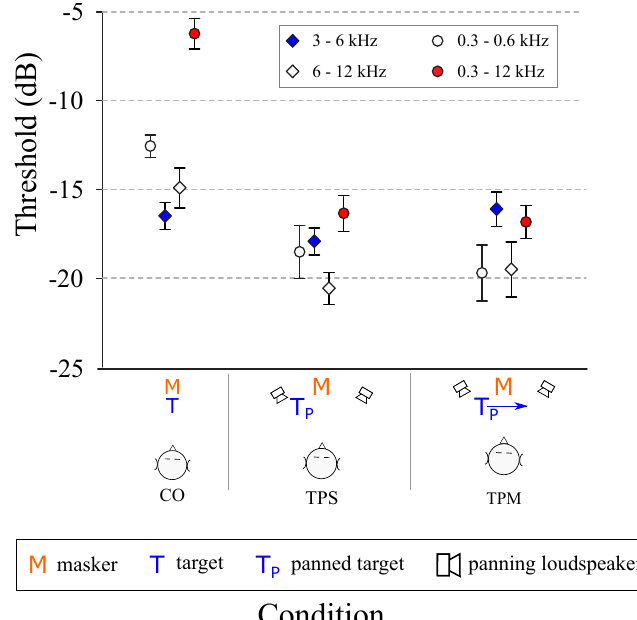
Figure 5. Mean detection thresholds across 10 listeners. Error bars indicate ± 1 standard error of the mean. Thresholds were measured the same as in Experiment 1. All conditions are labeled and schematically illustrated along the horizontal